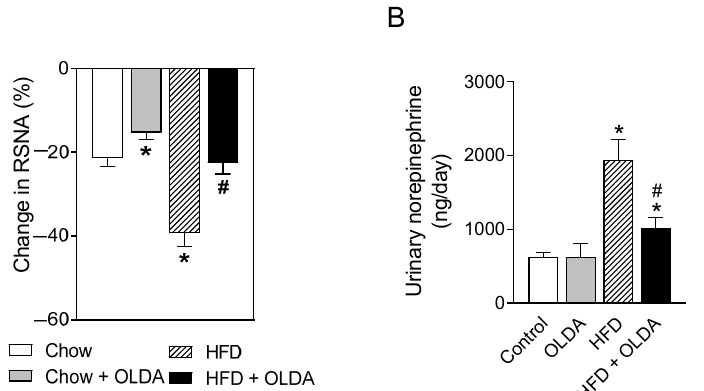
Figure 2. Effects of OLDA on afferent renal nerve function. The levels of plasma calcitonin gene-related peptide (CGRP) ( A ), substance P (SP) ( B ), and afferent renal nerve activity (ARNA) ( C ) response to intra-pelvis administration of capsaicin in chow-fed or high-fat-diet (HFD)-fed rats after 8 week of treatment with or without intrathecal N-oleoyldopamine (OLDA) treatment (1 ng/kg, daily). Values are means ± SE (n = 8). * p < 0.05 compared with that of the chow group; # p < 0.05 compared with that of the HFD group. Figure 3